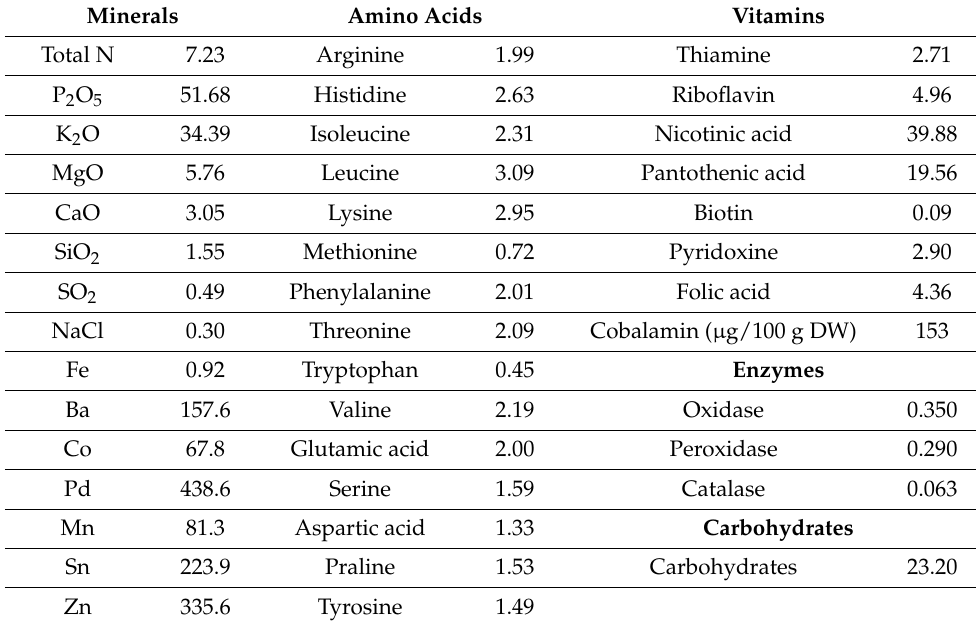
Table 3. Chemical analysis of activated yeast extract (mg/100 g DW *).